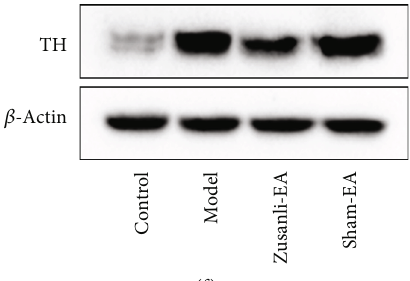
Figure 4: EA decreased neurogenic in fl ammatory on body surfaces in DSS-induced colitis rats. (a) The contents of pain-causing substances SP, BK, HA, and PGI2 in the rat skin tissues (corresponding to the L6 DRG) were examined by enzyme-linked immunosorbent assay (ELISA). (b) The contents of in fl ammatory factors IL-1 β , IL-6, TNF- α , PGE2, and IL-10 in rat serum were tested by enzyme-linked immunosorbent assay (ELISA). (c) Immunohistochemistry (IHC) for 5-HT expression in the rat skin tissues (corresponding to the L6 DRG). (d) Quanti fi cation of positive immunohistochemical (IHC) stain. (e, f) The expression of TH in L6 DRG of colitis rats was tested by Western blot analysis. ∗ P < 0 : 05 vs. control group, ∗∗ P < 0 : 01 vs. control group, # P < 0 : 05 vs. sham-EA group, ## P < 0 : 01 vs. sham-EA group. Data represents means ± SD